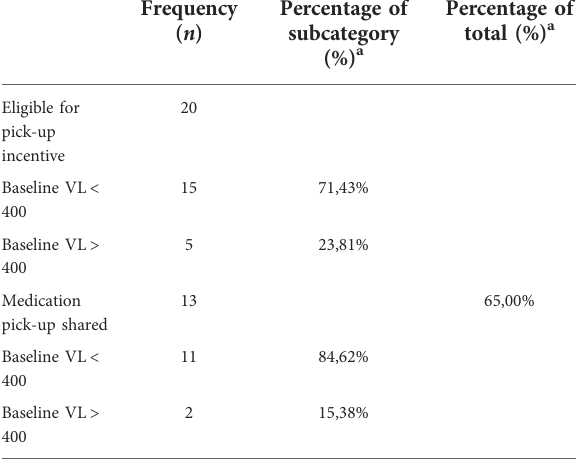
TABLE 4(A) monthly medication collection